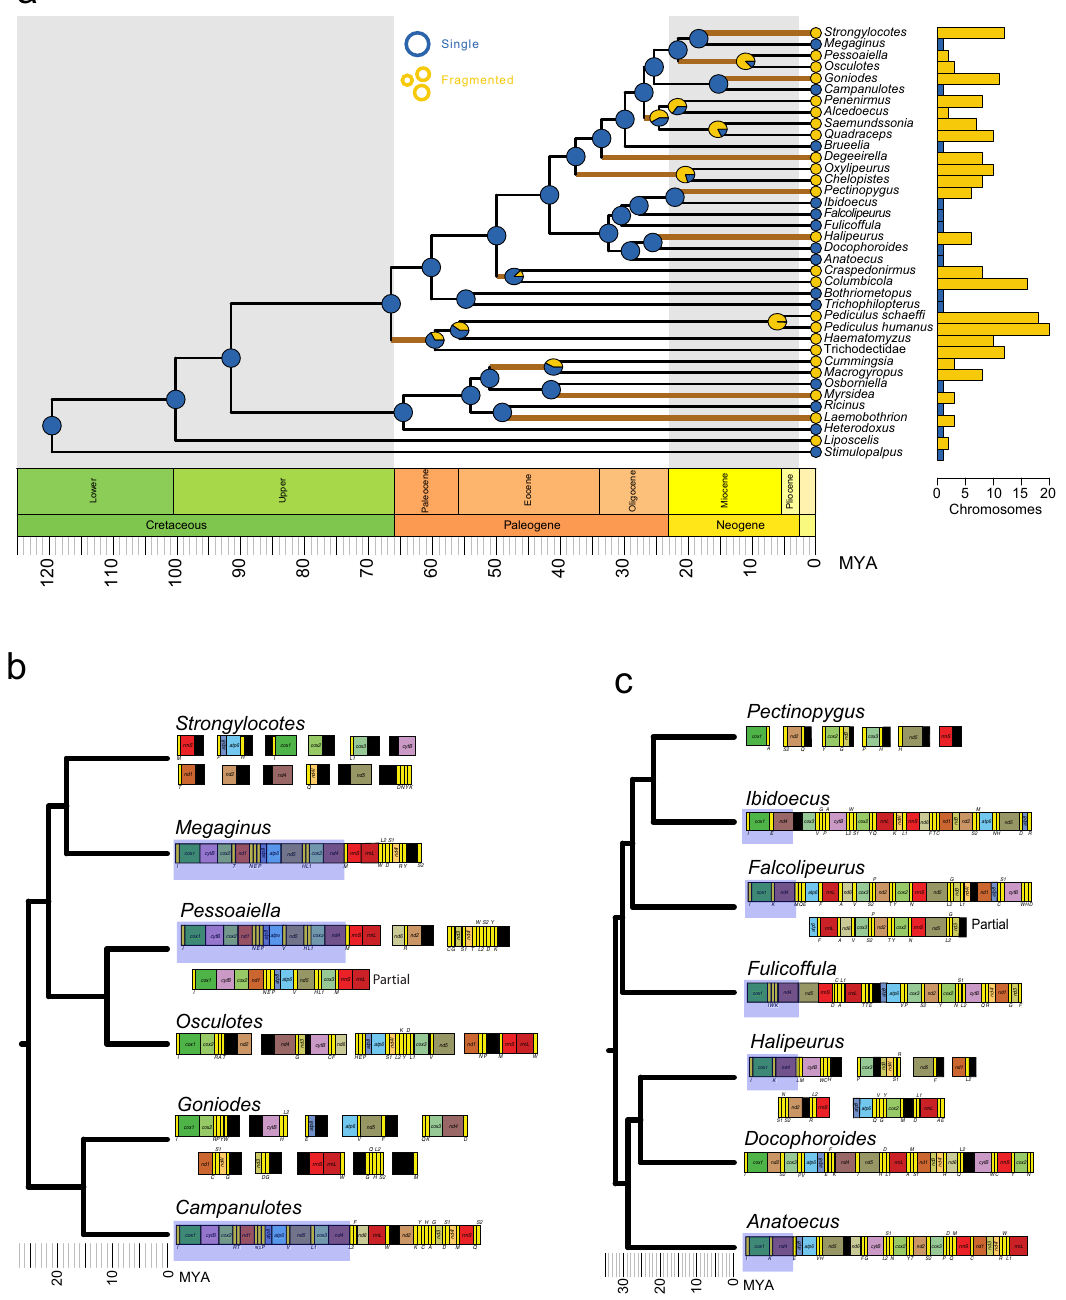
Fig. 1 Phylogenetic patterns of mitochondrial genome structure in parasitic lice. a Dated phylogenetic tree of 36 taxa of parasitic lice and two outgroup taxa, representing all major clades of lice adapted from a nuclear gene phylogeny 28 Circles at the tips indicate the mitogenome structure for that taxon: fragmented (yellow) or a single chromosome (blue). Pie charts at the internal nodes show the ancestral reconstruction of mitogenome structure, with the area of each color representing the relative likelihood of fragmented or single chromosomes. Brown branches indicate plausible transitions from single to fragmented mitogenomes and were used as foreground branches in tests for relaxed selection. Bar plot adjacent to the phylogeny shows the number of mitogenome fragments recovered for each taxon. b , c Details of the mitogenome structure for two clades of parasitic lice. Each chromosome has been arbitrarily (although consistently) linearized. Fragmented mitogenomes are shown with separate rectangles. Genes are colored as follows: atp6 and atp8 : shades of blue; cox1-cox3 : shades of green; cob : purple; nad1-nad6 : shades of brown; rrnL and rrnS : shades of red; tRNA genes: yellow. Conserved blocks of genes are highlighted by blue